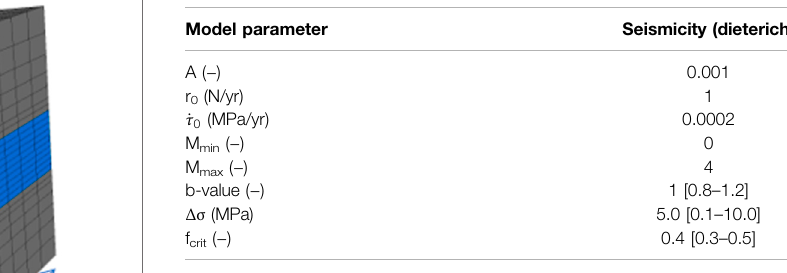
TABLE 2 | Parameters and ranges for modelling rate-and-state seismicity and frequency-magnitudes distributions. Values between square brackets indicate a stochastic range of input parameters (uniform